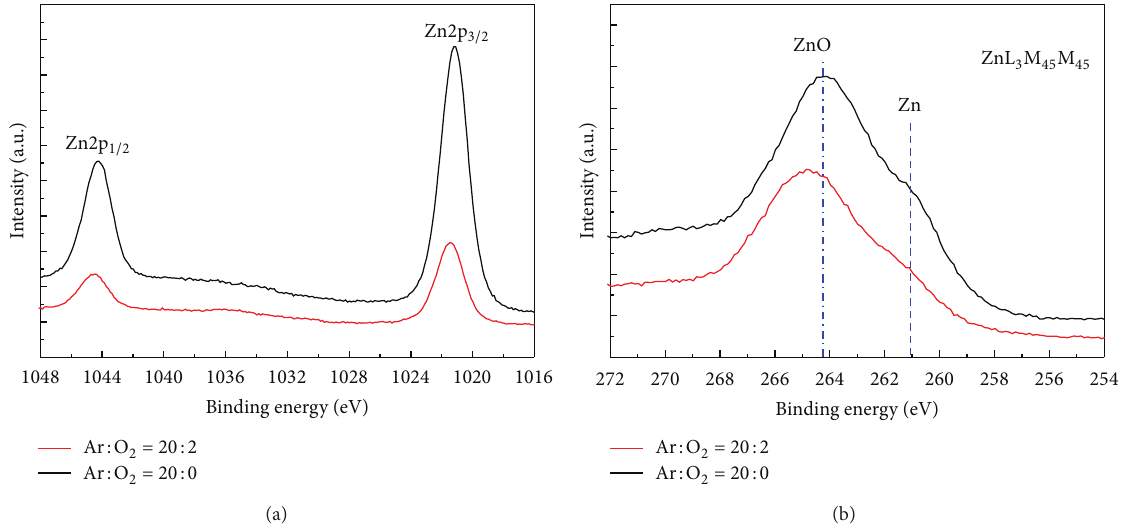
Figure 2: (a) XPS data of Zn 2𝑝 and (b) AES data of Zn LMM in ZnO films deposited under 𝑃